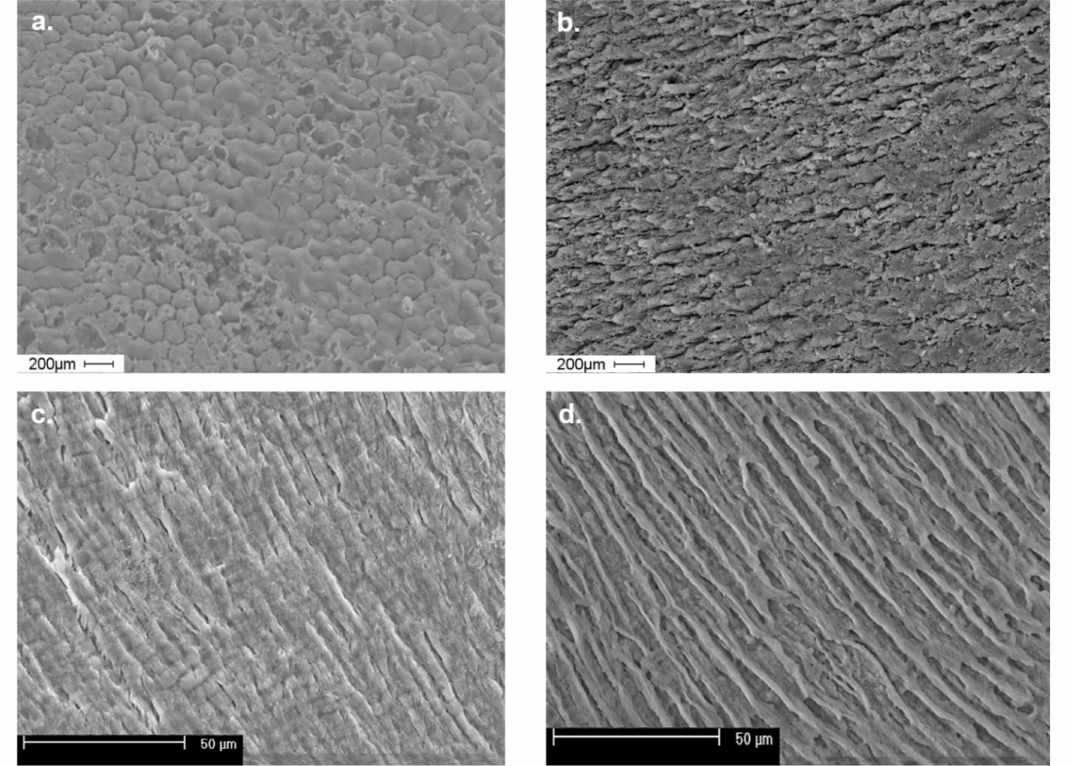
Figure 1. Scanning electron microscopy (SEM) imaging in a healthy and fluorotic tooth: ( a ) buccal enamel surface without fluorosis; ( b) buccal enamel surface with fluorosis; ( c ) cross-section of enamel without fluorosis; ( d ) cross-section of enamel with fluorosis. Scale is shown in the left bottom corner of each